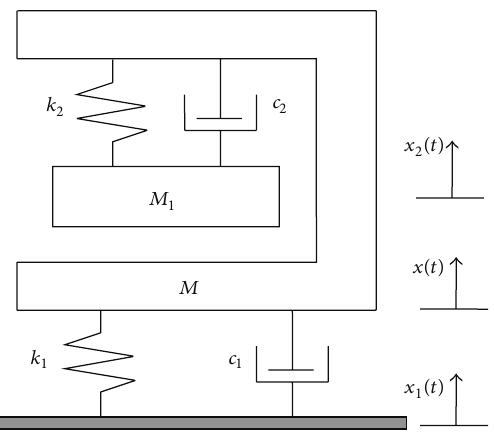
Figure 17: For Example 5, seat-person model of single-degree of freedom system